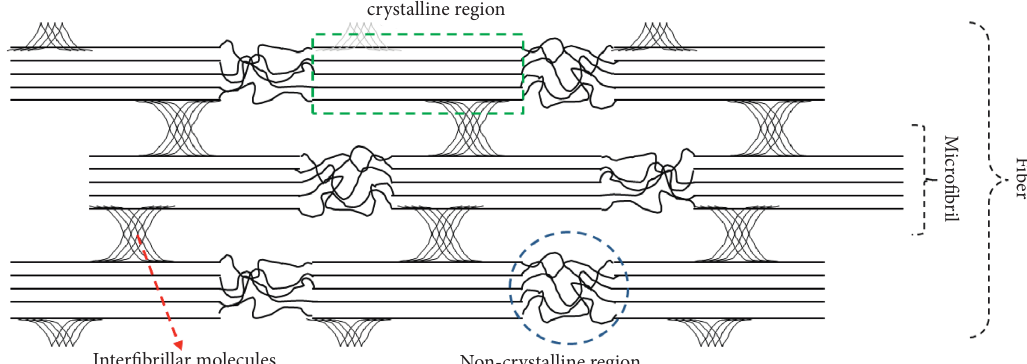
Figure 1: The crystalline and amorphous structures of cellulose. The red dotted arrow is the degradation of the amorphous or noncrystalline region with the weakest bond, this location being the site of the production of nanocrystalline cellulose or interfibrillar